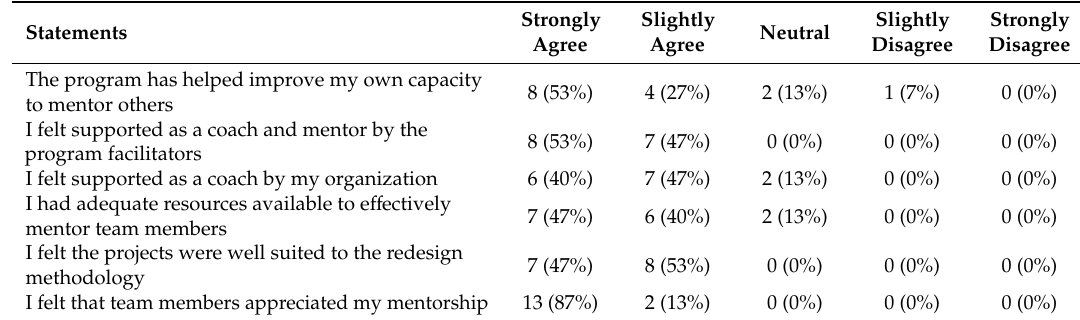
Table 2. Experiences of expert coaches ( N =